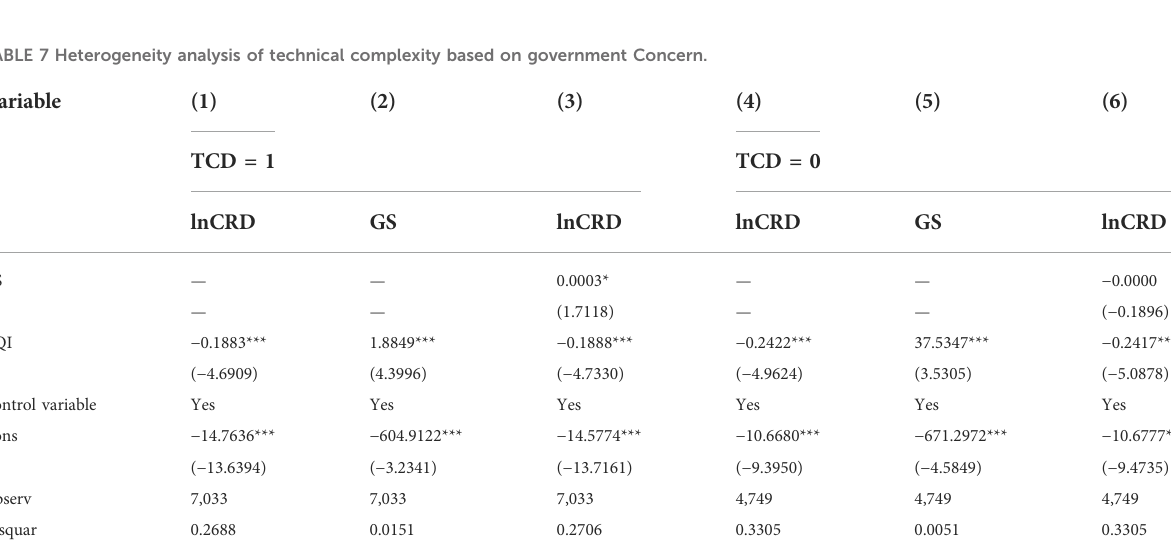
Control variable